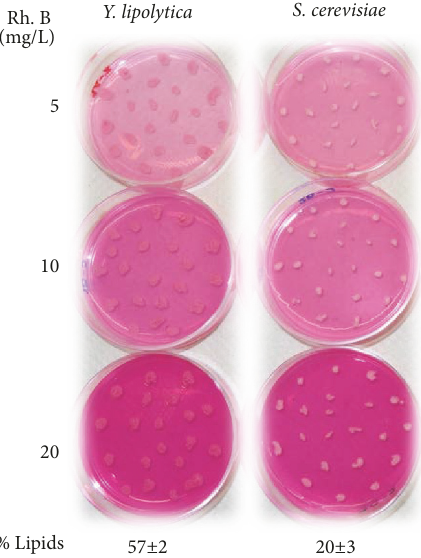
Figure 2: Y. lipolytica and S. cerevisiae were cultured on N-limited medium at three different concentrations of Rhodamine B (Rh.